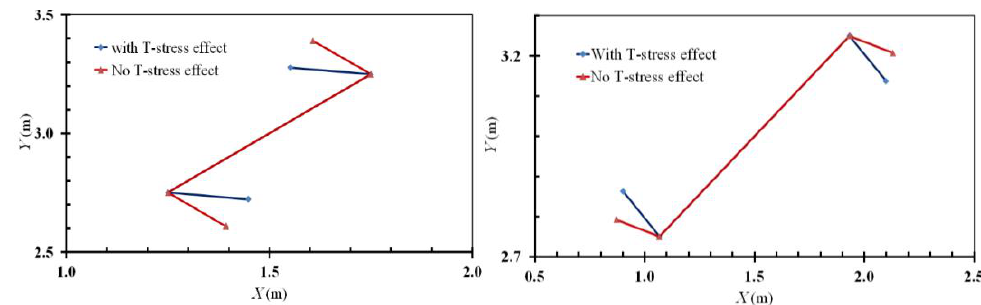
Figure 10. 30-degrees slanted center crack: under compression (left), under tension (right)